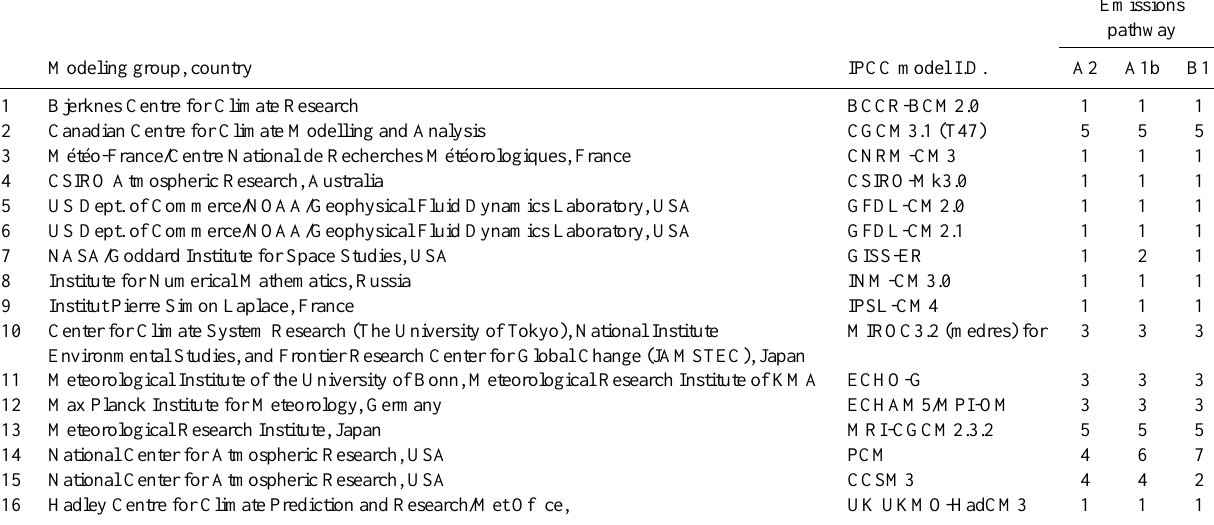
Table 1. Downscaled WCRP CMIP3 GCMs and emissions